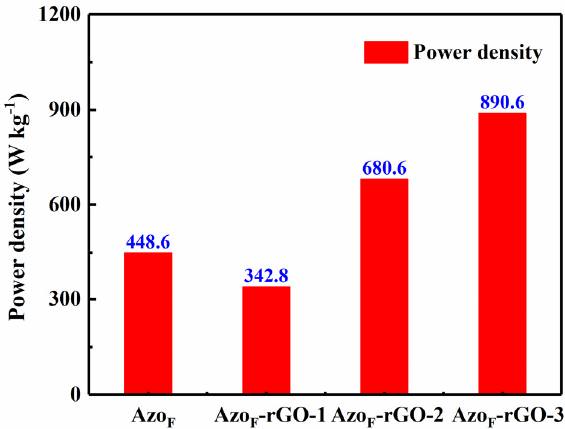
Figure 6. Power density of Azo F and Azo F -rGO after 1, 2 and 3-times reaction. Table 2. Performance of different photothermal conversion